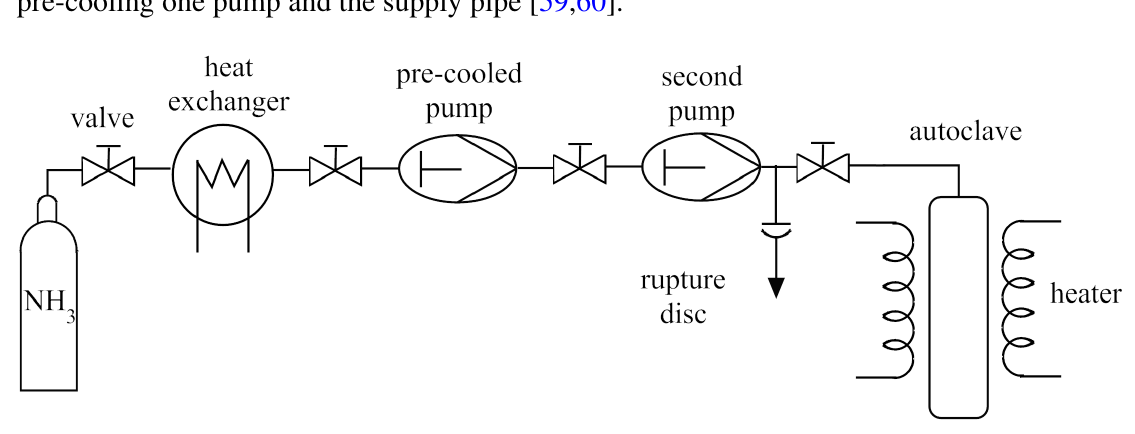
Figure 3. Flow chart of an ammonothermal reaction setup for the simultaneous pressure and temperature control during reaction using two pumps. The heat exchanger is used for pre-cooling one pump and the supply pipe